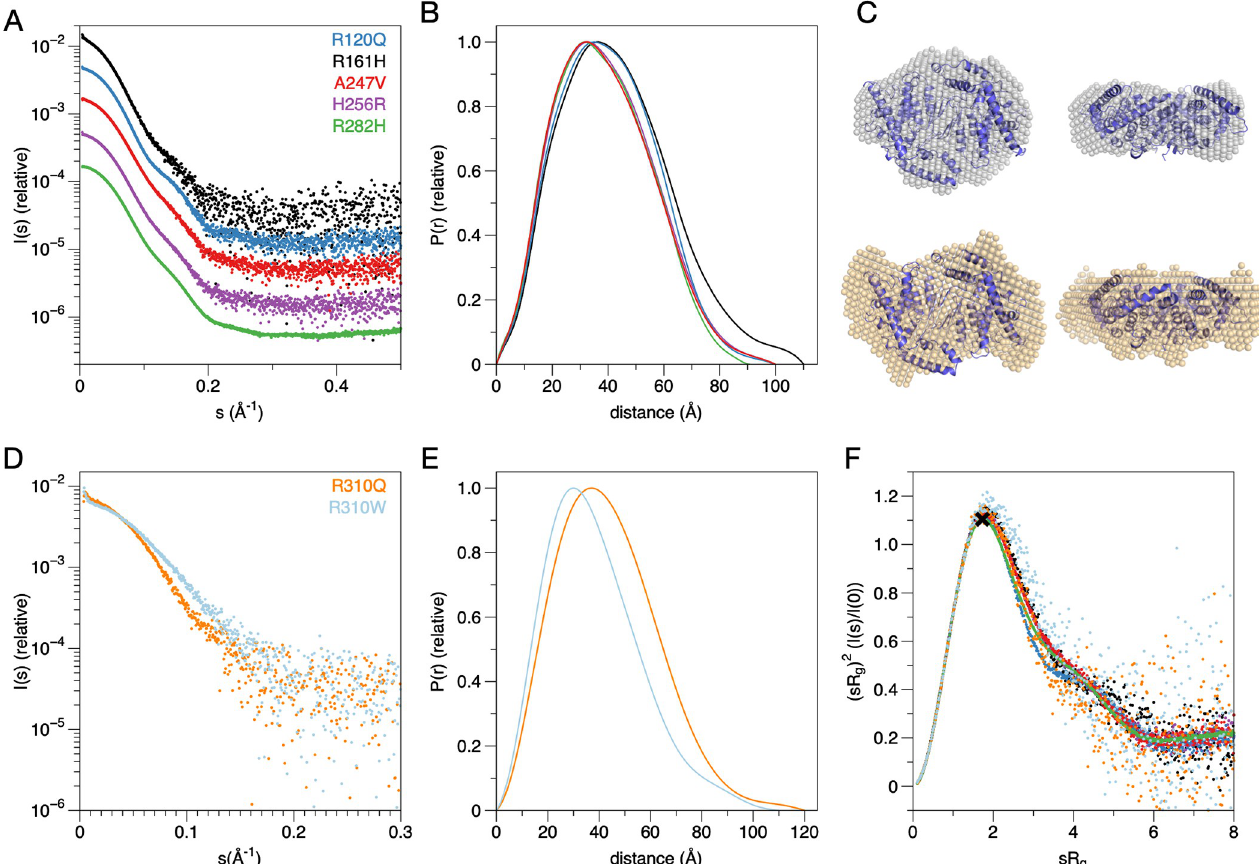
Fig 3. SAXS analysis. A. SAXS curves for the mutants in the GDAP1 Δ 303–358 construct. The curves have been displaced along the y axis for clarity. B. Distance distributions for the curves in A. R161H shows a more open conformation than the other variants. C. Top: Dummy atom model of R282H superimposed with a structure based on the collapsed conformation of wild-type GDAP1 Δ 295–358 [12]. Bottom: Dummy atom model of the R310Q mutant in GDAP1 Δ 319–358, superimposed on the same structure, indicating additional volume for the C-terminal extension. D. SAXS curves for the mutants in the GDAP1 Δ 319–358 construct. The dominant monomer peak from SEC was used for R310W and the dimer peak for R310Q. E. Distance distributions for the curves in D. F. Dimensionless Kratky plots for all constructs show similar levels of rigidity and globularity. The cross marks the location of the peak in a perfect globular